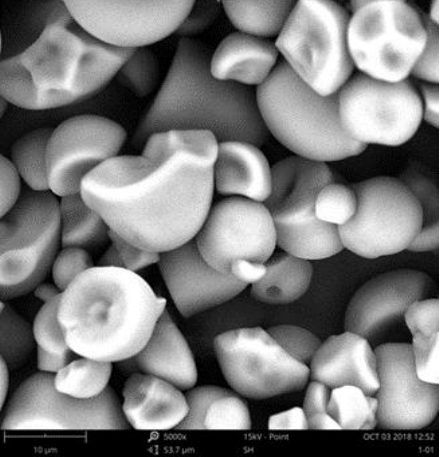
Figure 2. Electron microscope scan of native cassava starch.